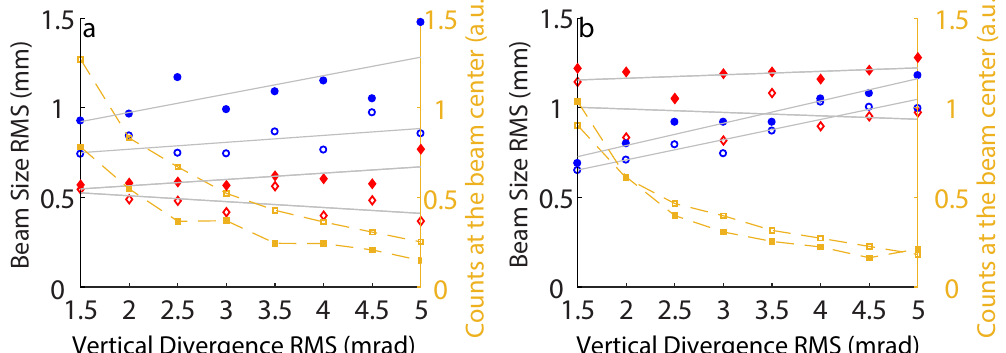
Figure 10. Counts at the center of the beam ( (cid:3) ), horizontal ( (cid:5) ), and vertical ( ◦ ) beam RMS size versus initial divergence for the low ( void symbols ) and high ( filled symbols ) skew (Table 2) for the electron distribution of Figure 2a, Table 1, ( a ) before and ( b ) after the undulator with the “undulator-entrance” optics and “undulator-exit” optics, respectively. Each point averaged over 5 repetitions of the